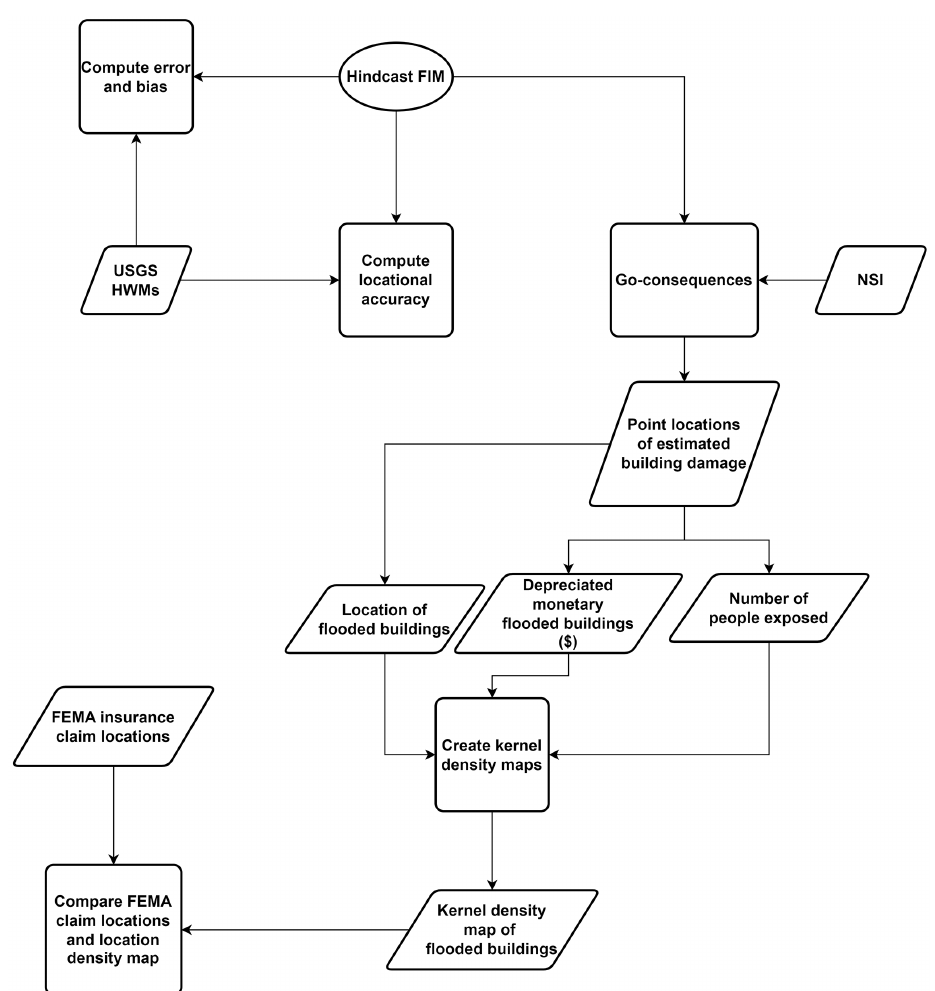
Figure 3. Flow diagram describing the two-pronged evaluation process undertaken to examine the spatial differences in each FIM and the differences in exposure and consequences estimated by each FIM. The dollar symbol denotes US dollars.